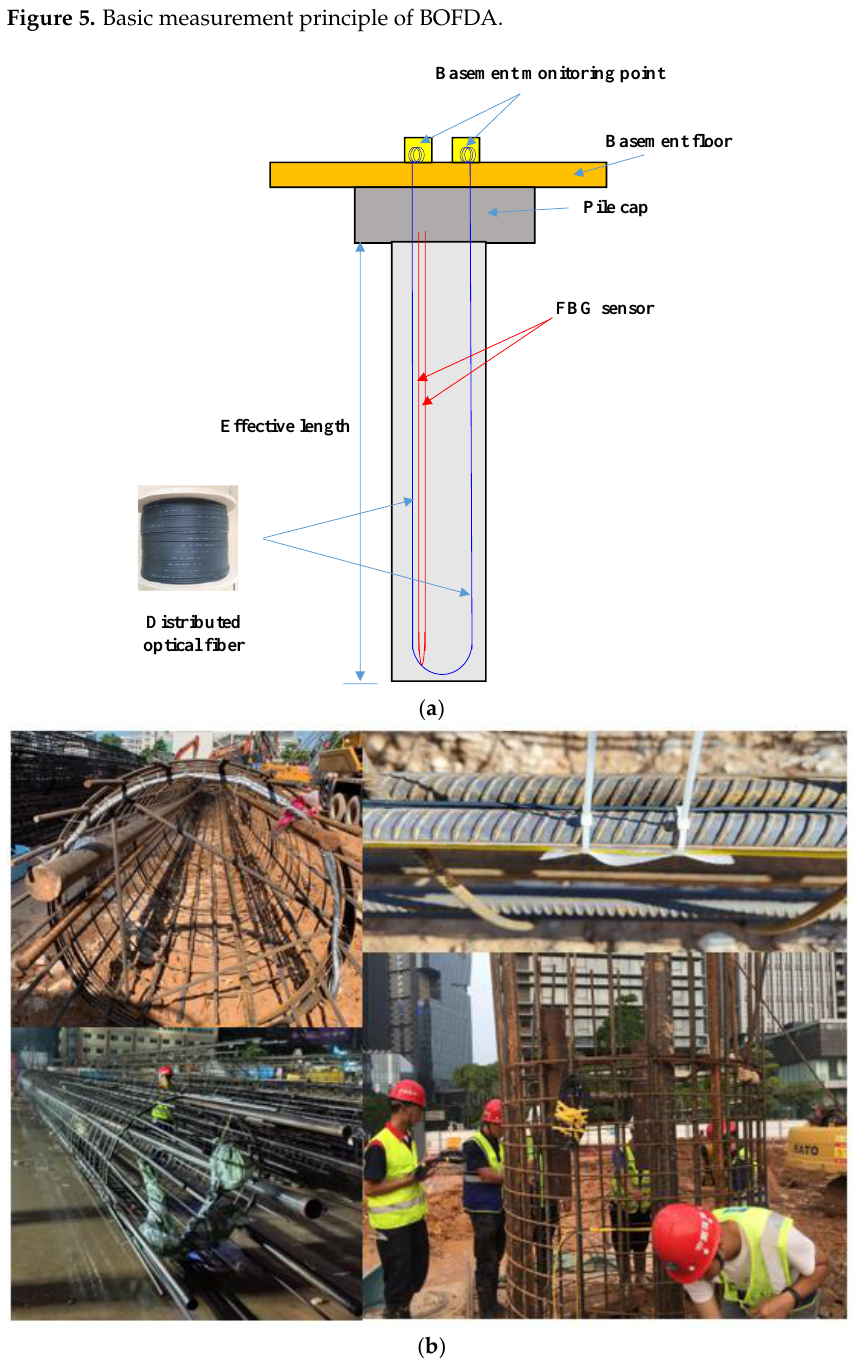
Figure 6. Sensor layout scheme: ( a ) sensor layout; ( b ) field installation.